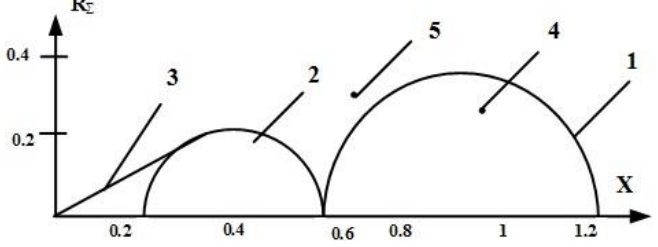
Figure 6. Zone 1 of synchronous self-excitation and zones 2 and 3 of asynchronous self-excitation.